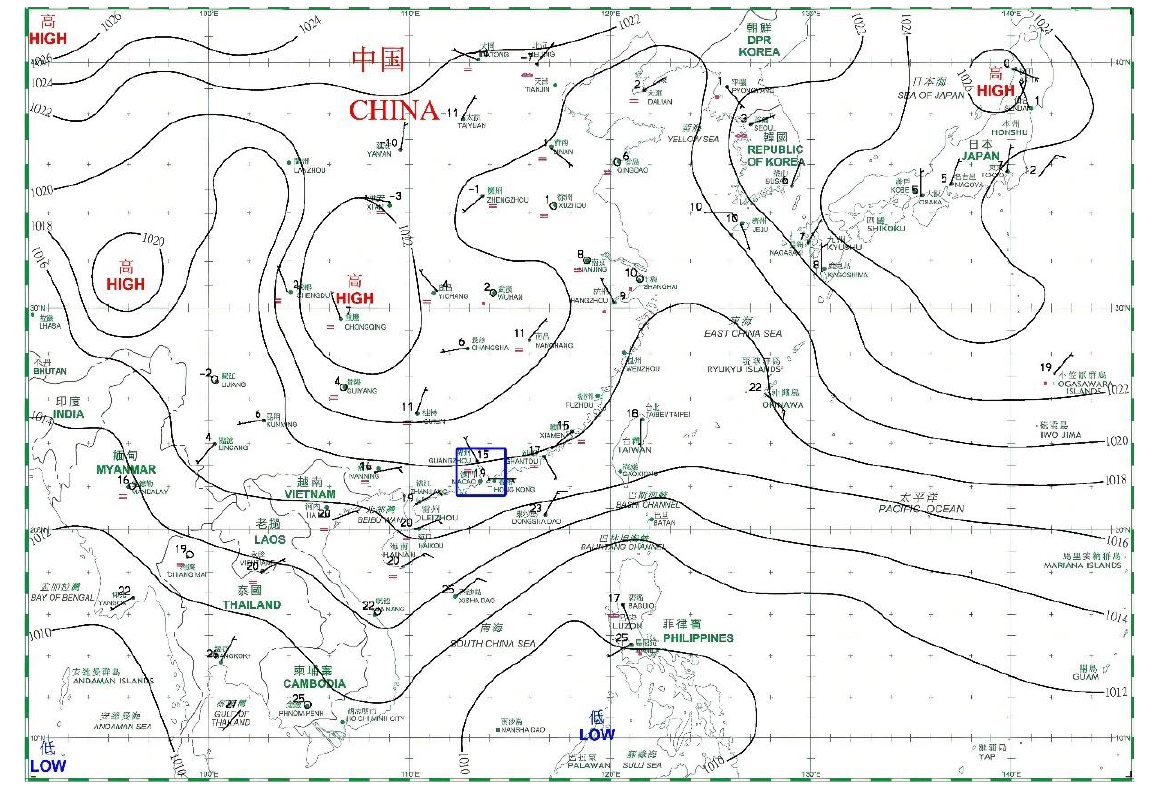
Figure 1. Hong Kong surface weather chart from Hong Kong Observatory at 0800 LST 27 December 2020, the blue rectangle is the Pearl River Delta (PRD) region in China.